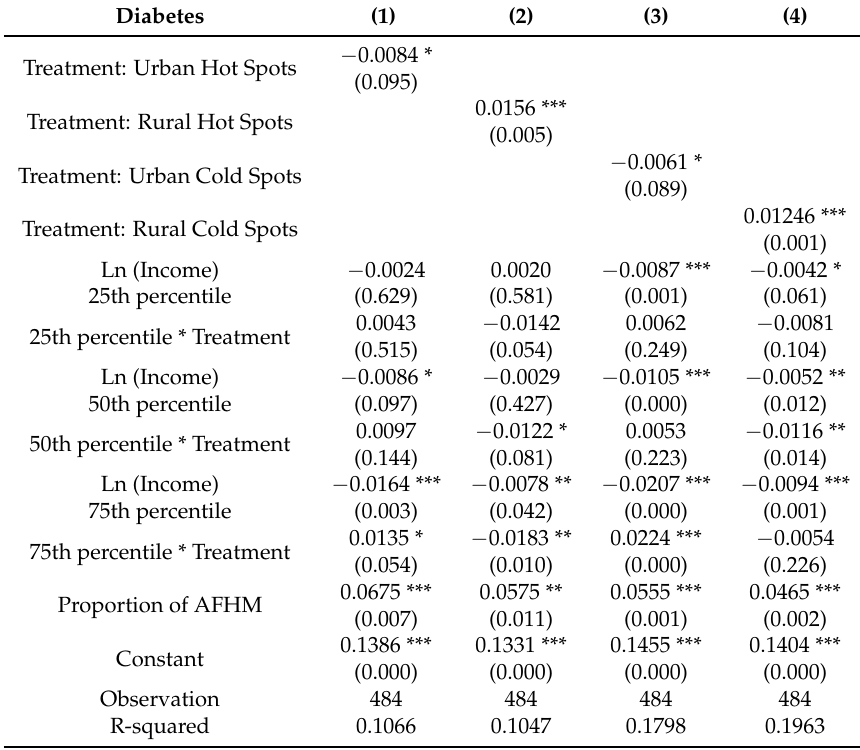
Table 1. The impacts of urban and rural hot (and cold) spots on diabetes